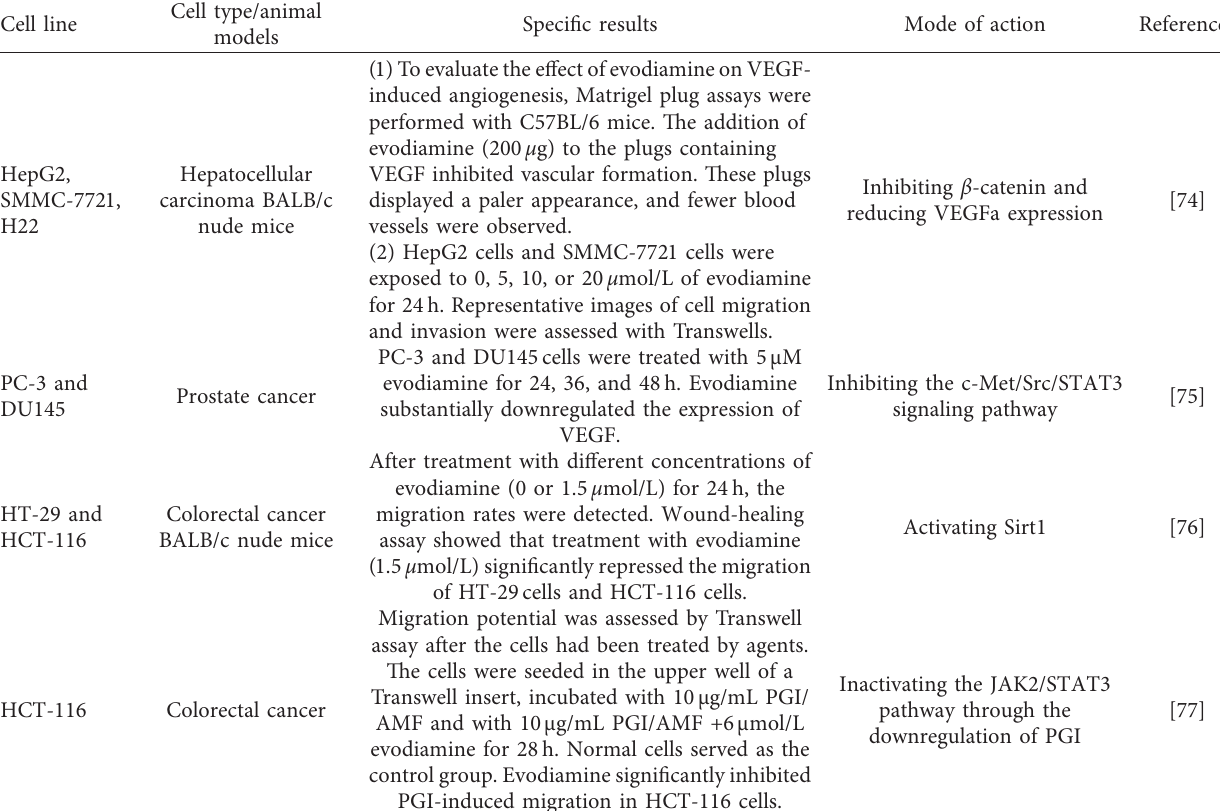
Table 4: Inhibition of microangiogenesis and migration by evodiamine in cancer cell lines in vitro or in vivo. Cell